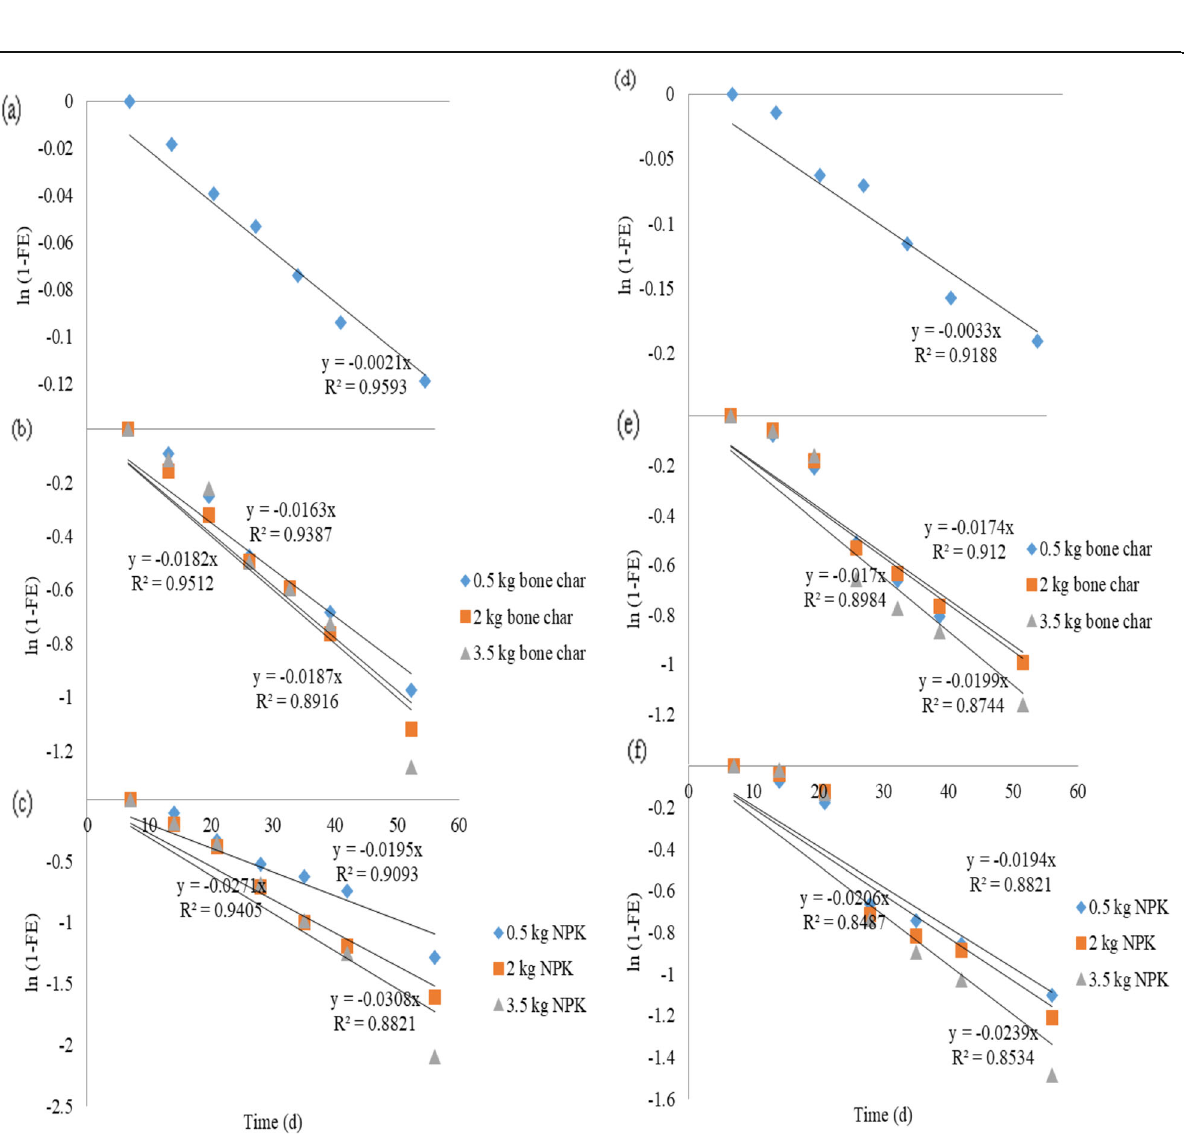
Fig. 6 First order kinetic pattern for ( a ) THC reduction of control sample (b ) THC reduction of bone char treated soil ( c ) THC reduction of NPK treated soil ( d ) TOC reduction of control sample ( e ) TOC reduction of bone char treated soil ( f ) TOC reduction of NPK treated